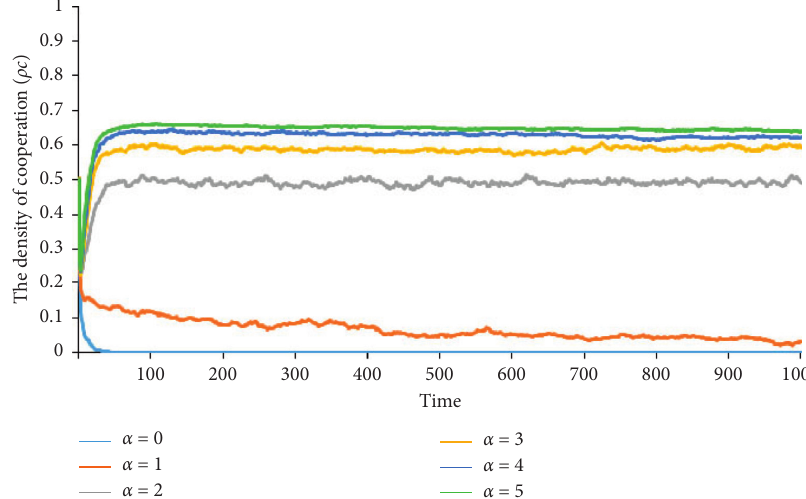
Figure 7: Time course of the density of cooperation for different values of α , the depicted is obtained in PDG for u � 0 and b � 1.3. It is observed that the density of cooperation will rise with the increase of α .